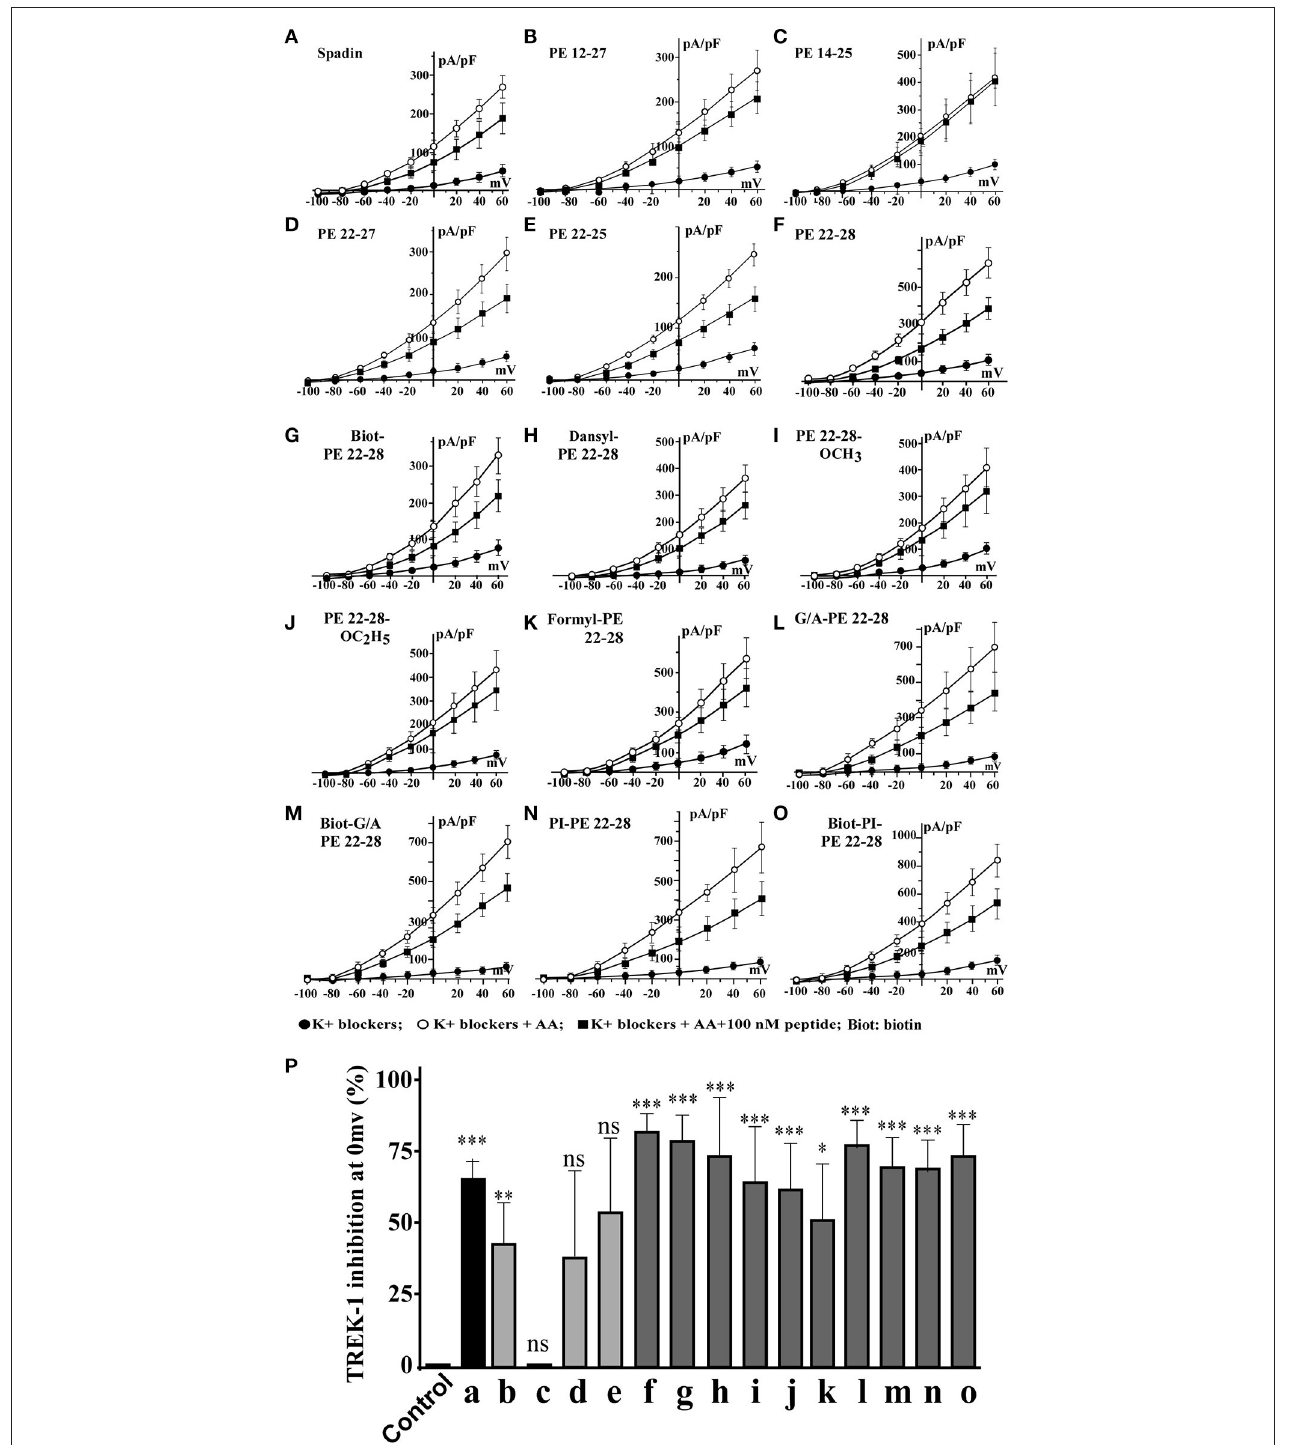
FIGURE 2 | I = f(V) curves and % of TREK-1 inhibition. (A–F) , current density curves obtained with spadin and shortened peptides described in Figure 1C . (G–O) , current density curves obtained with PE 22-28 analogs. (P) Inhibition percentages of TREK-1 current measured at 0 mV for corresponding peptides described from “ A ” to “ O ”. Control value was obtained by using a solution of 0.9% NaCl. ns, not significant. * p < 0.05, ** p < 0.01, *** p < 0.001.